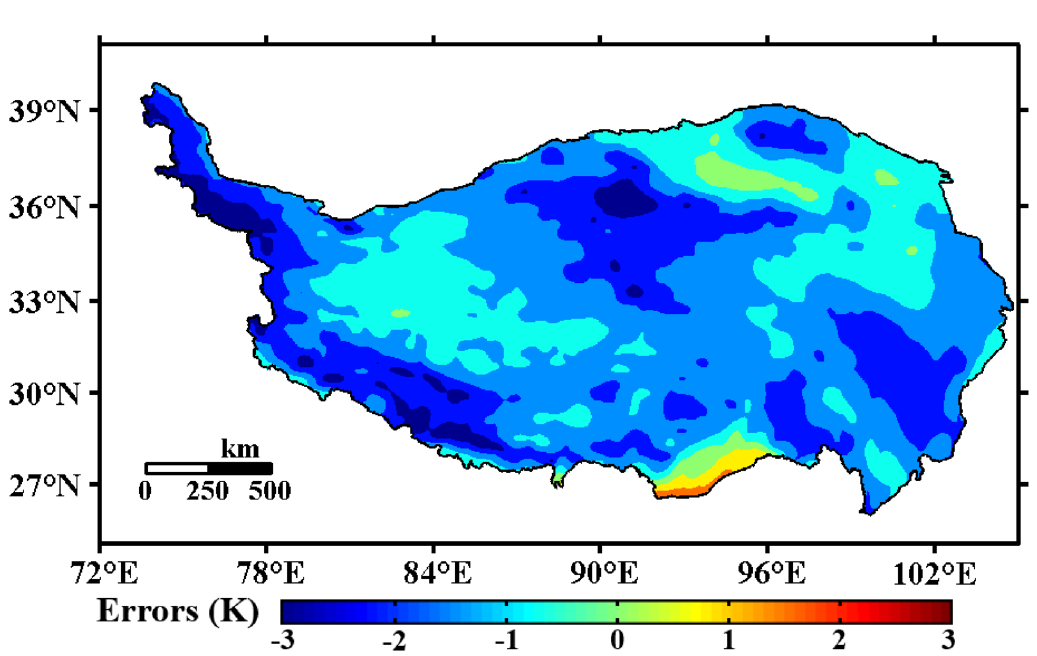
Figure 12. Errors of the ERA5 reanalysis data (annual average of 1981–2020, unit: K, Software: MATLAB 2014, https:// ww2. mathw orks. cn/ produ cts/ matlab.